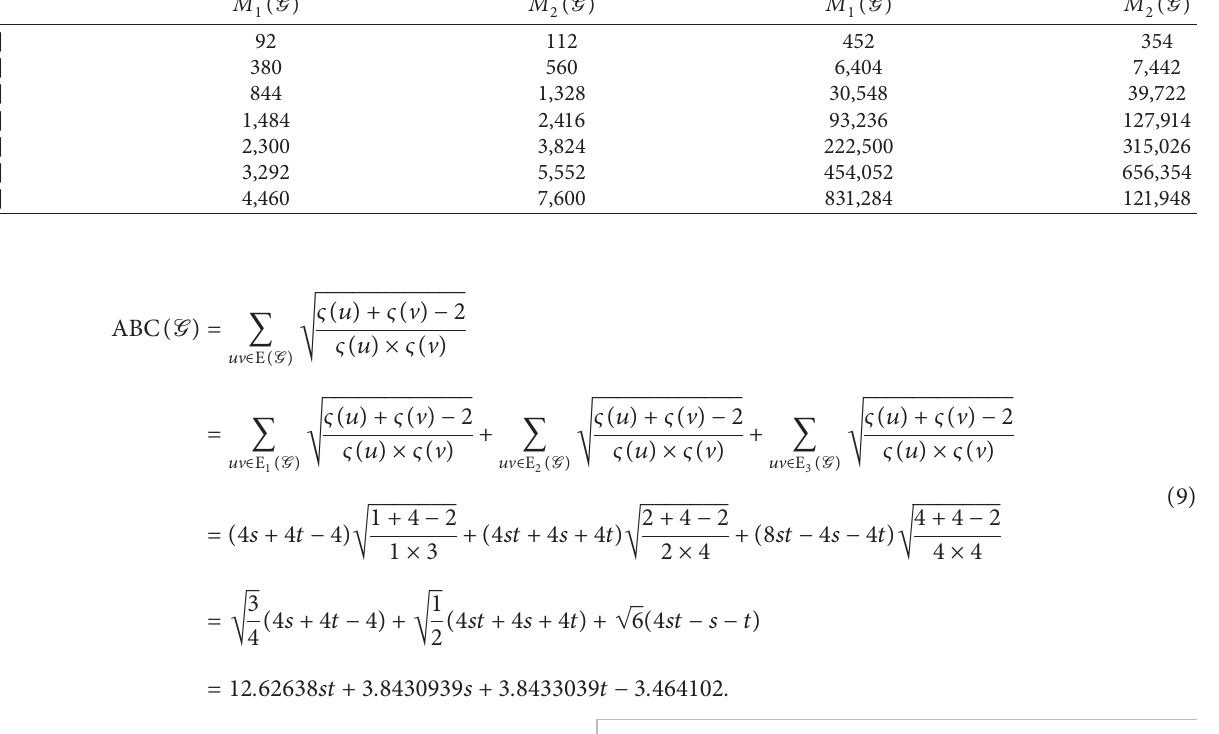
( G ) , M ( G ) , M ( G ) , and M 1 2 1